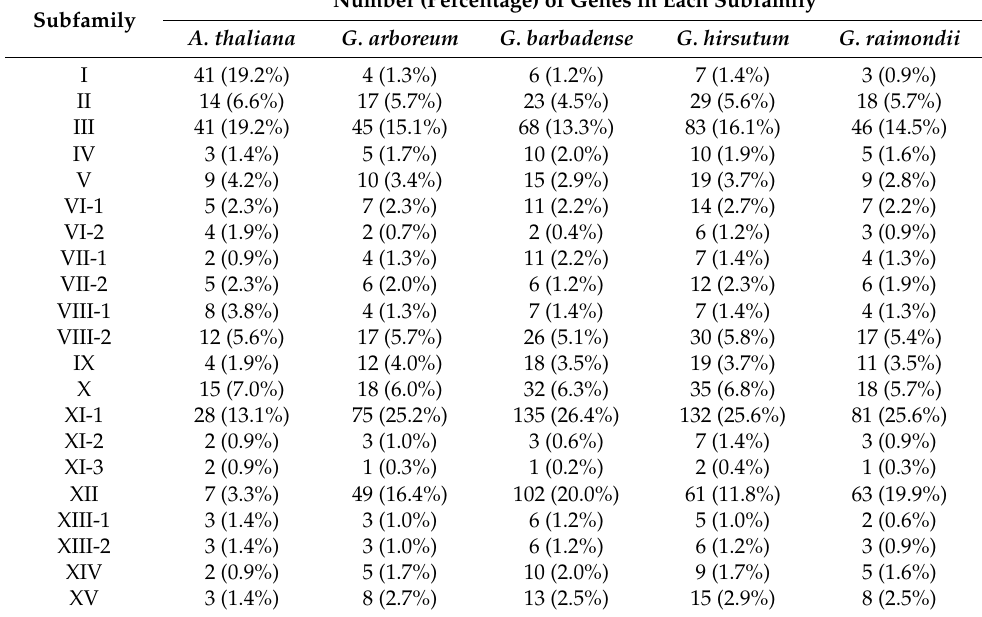
Table 1. Statistics of A. thaliana and Gossypium LRR-RLK gene distribution among different subfamilies. For both A. thaliana and four Gossypium species, the number of LRR-RLK genes belonging to each subfamily were counted respectively. The corresponding percentage in all LRR-RLK genes from specific species was computed and indicated in brackets. Number (Percentage) of Genes in Each Subfamily